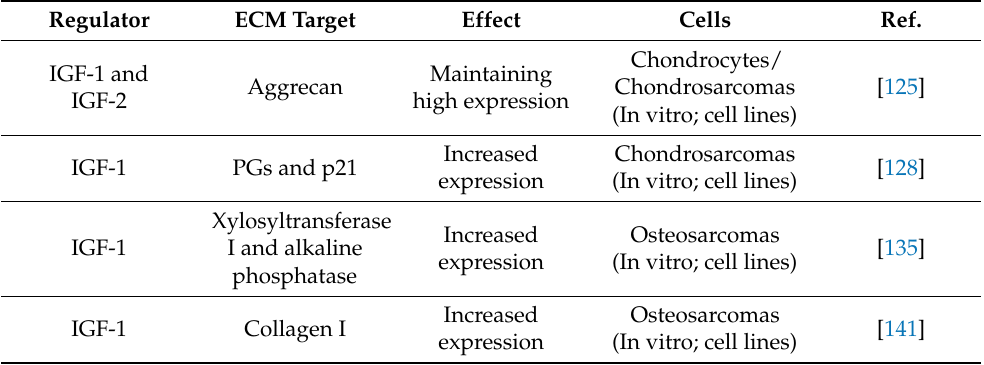
Table 1. Summary of the IGF-signaling effects on ECM molecules’